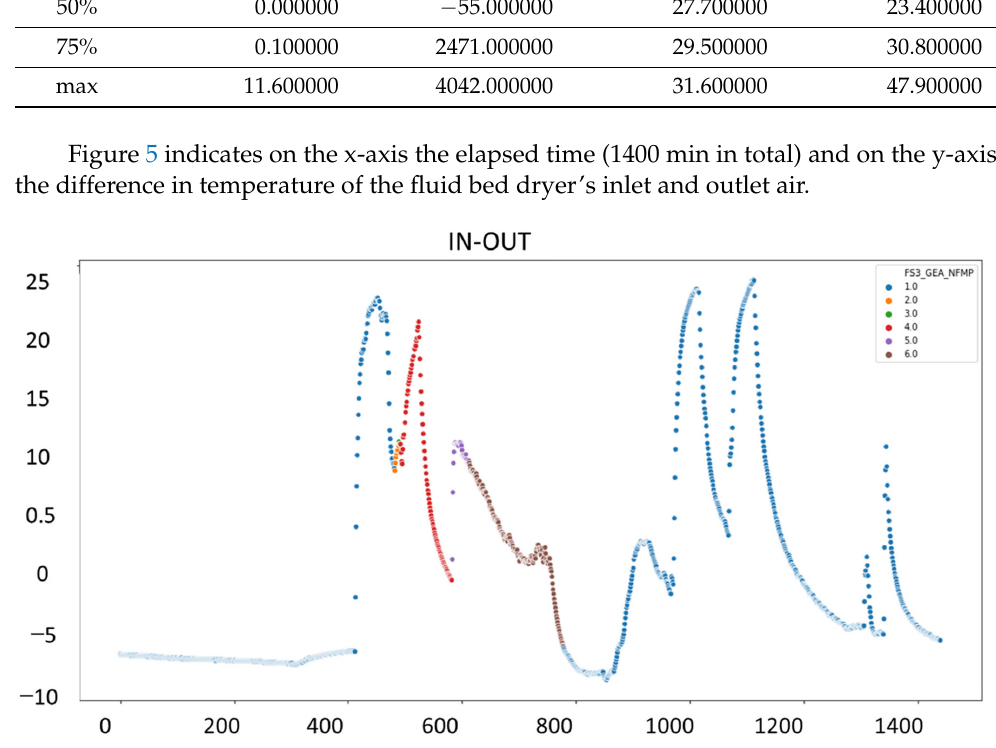
Figure 5. Plot of phases of the drying process.